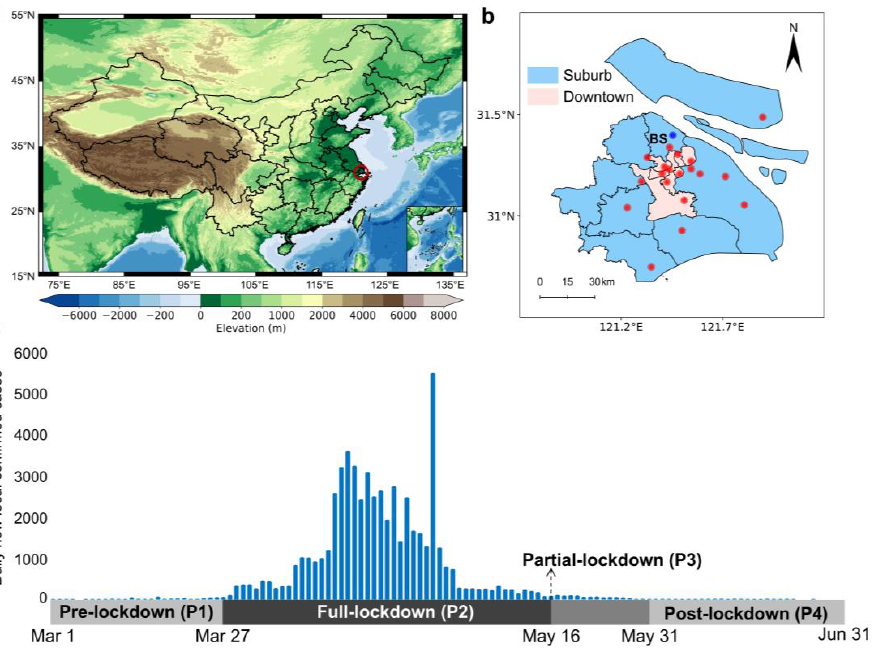
Figure 1. ( a ) The topography of China. The red circle represents the location of Shanghai; ( b ) suburbs and downtown Shanghai. Bold black text indicates the location of the BS district, red dots represent the 19 air quality monitoring stations, and the blue dot represents the BS meteorological station; ( c ) the study time series of daily COVID-19 new local confirmed cases from March 1 to June 31 (i.e., from P1 to P4).